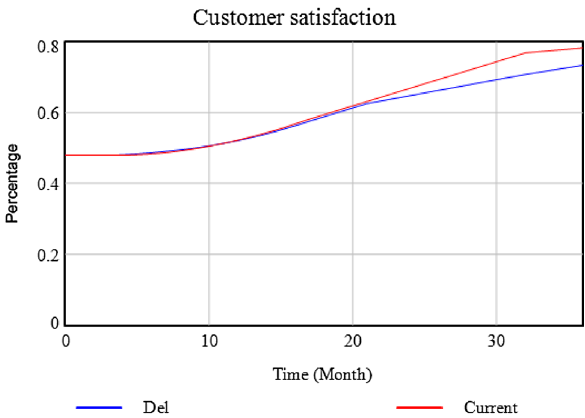
Fig. 7 The effect of eliminatingthe cost of compliance withthe region’s ethical values on customer